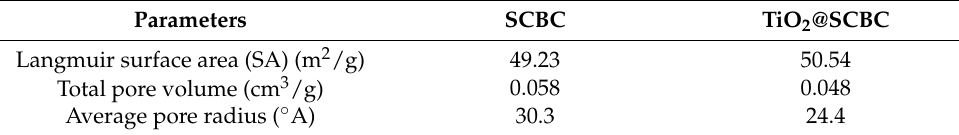
Figure 4. BET analysis of SCBC and TiO 2 @SCBC samples. Table 3. Brunauer-Emmett-Teller (BET) analysis of the SCBC and TiO 2